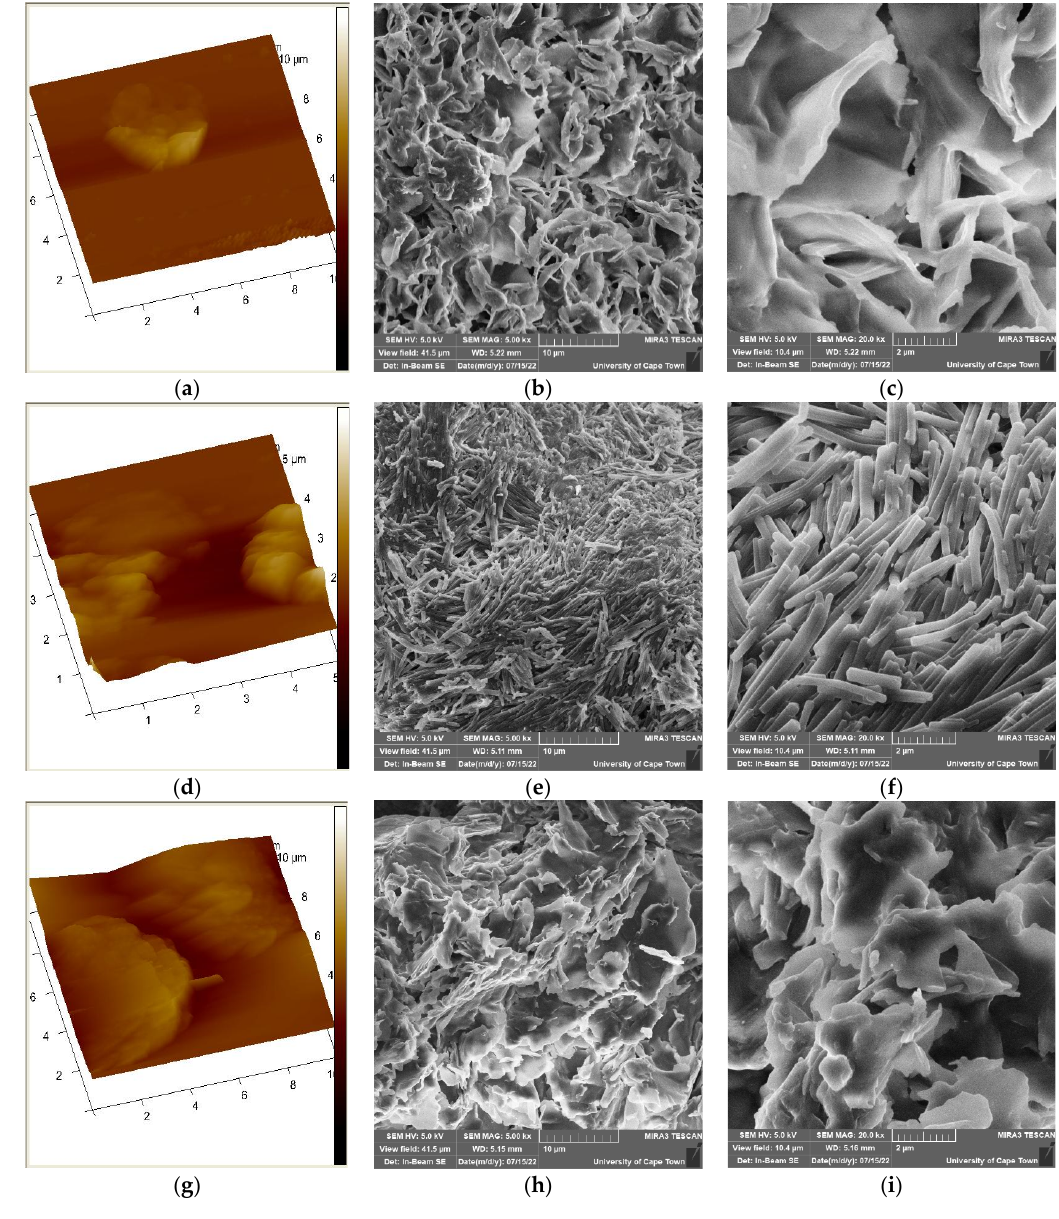
Figure 6. AFM ( a,d,g ) and SEM images for the prepared NiSa ( b , c ), NiSb ( e , f ), and NiSc ( h , i ) nano- particles.